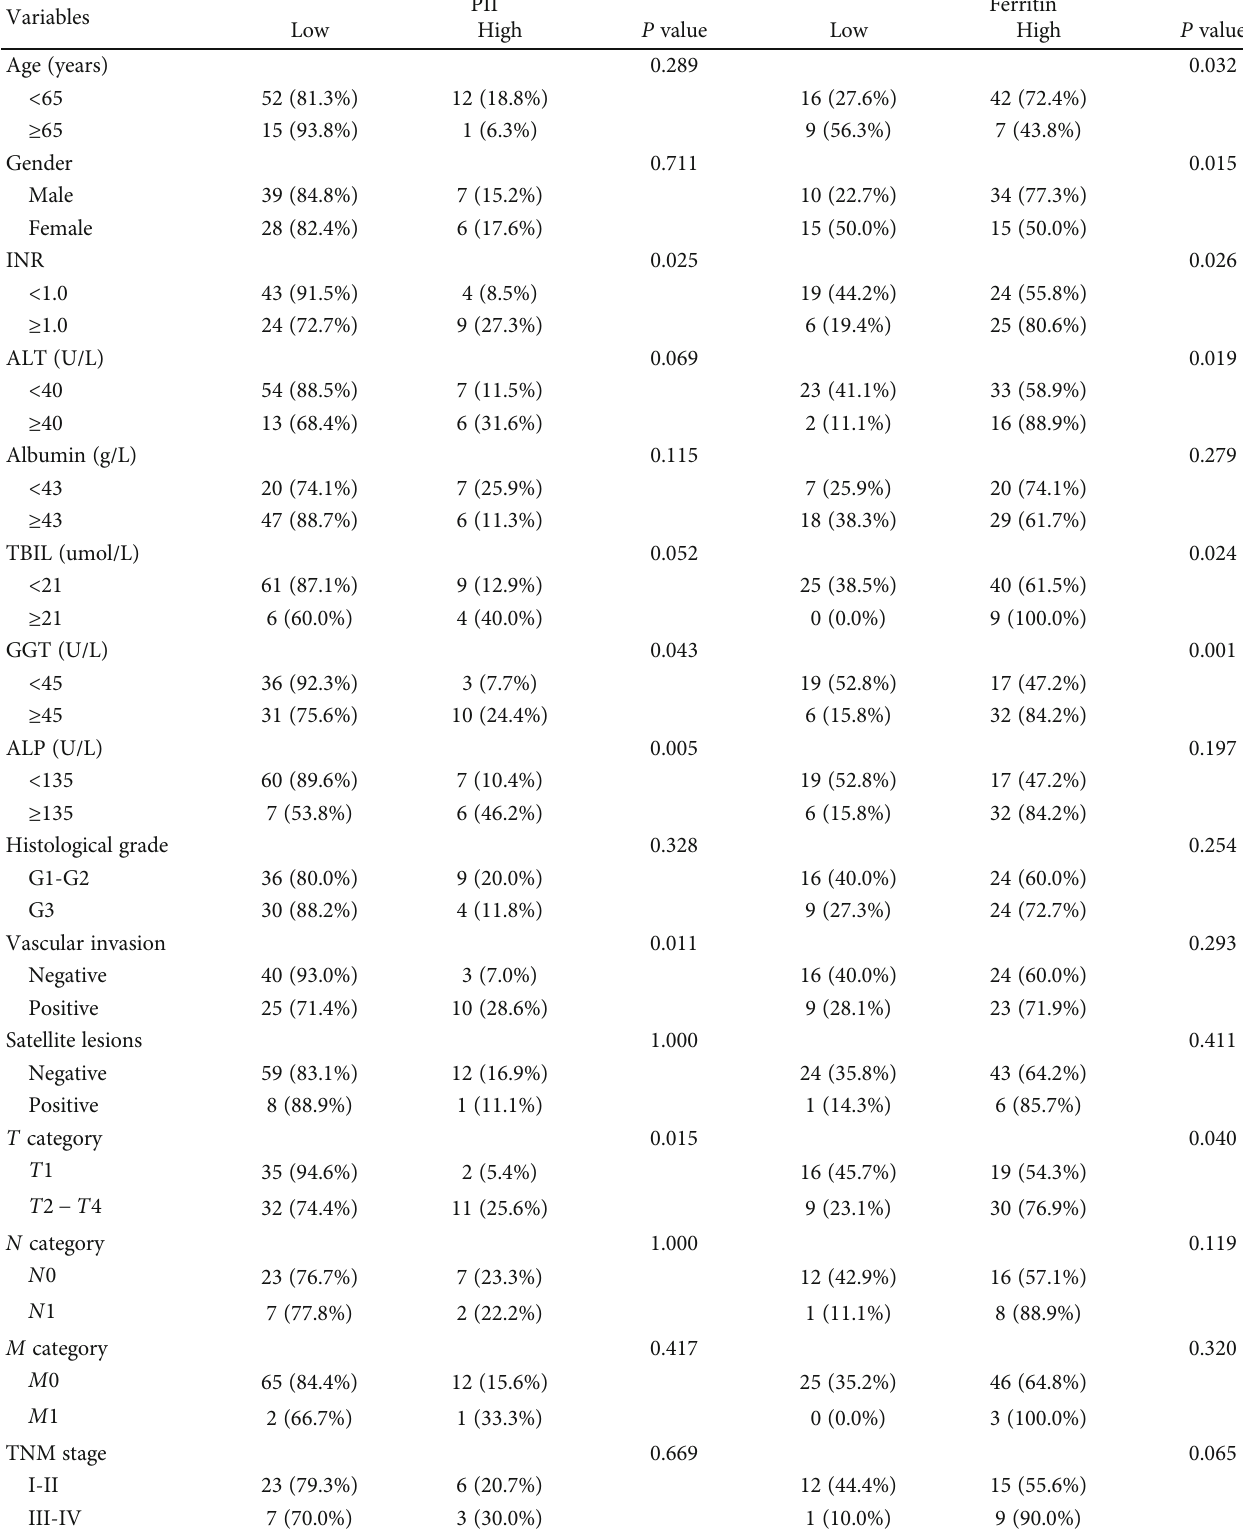
Table 5: Association of PII and ferritin with demographic and clinicopathological characteristics in small-duct type ICC of training cohort. PII Variables